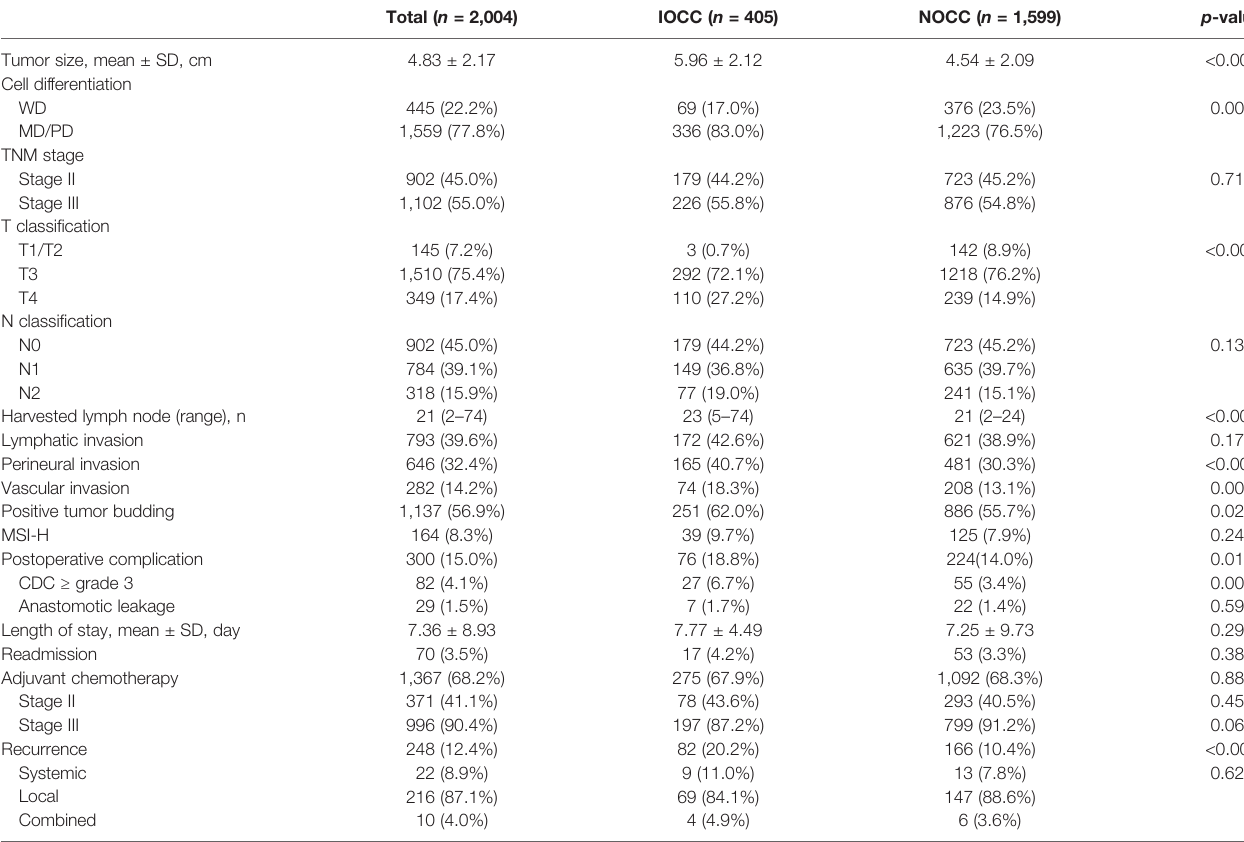
TABLE 2 | Postoperative outcomes of incomplete obstructive colon cancer (IOCC) and non-obstructive colon cancer (NOCC). Total ( n =